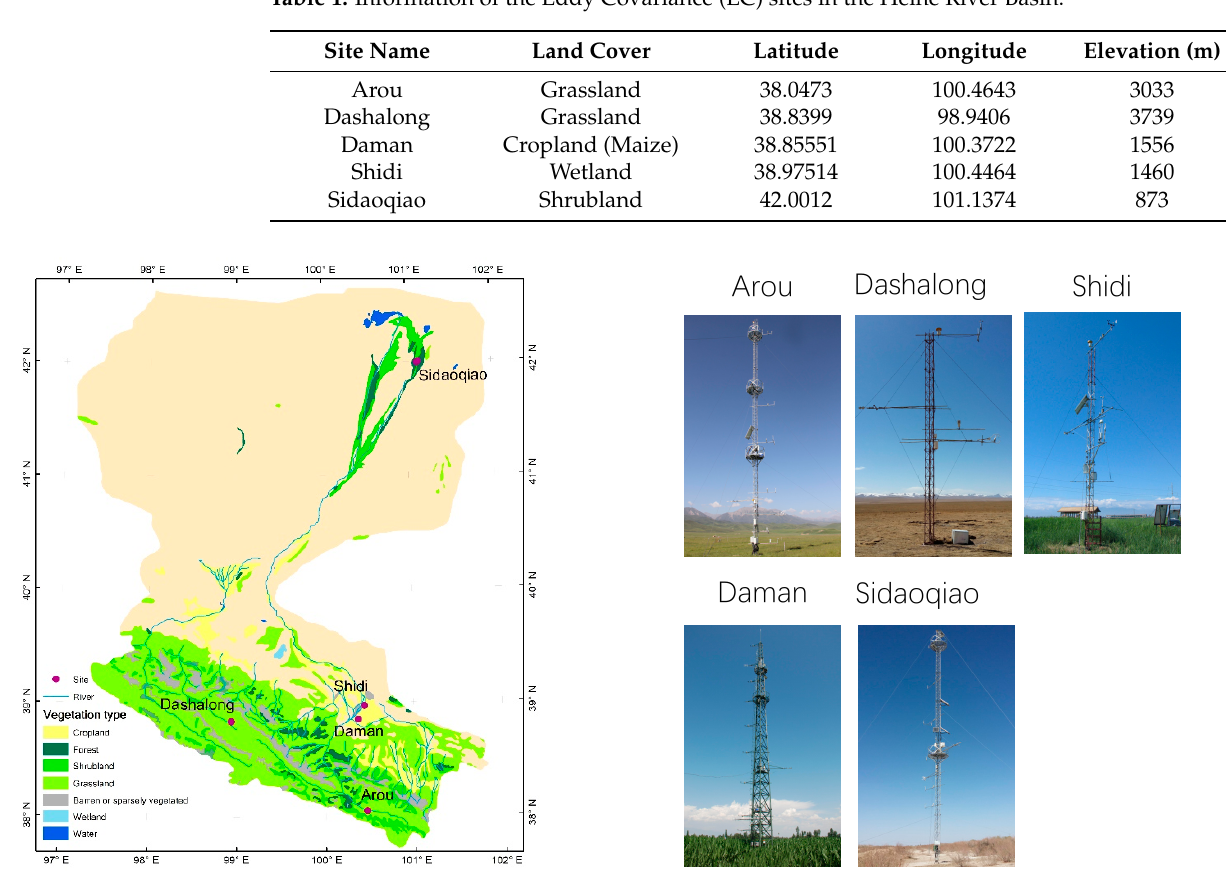
Figure 1. Distribution of the study sites in the Heihe River Basin. Table 1. Information of the Eddy Covariance (EC) sites in the Heihe River Basin.